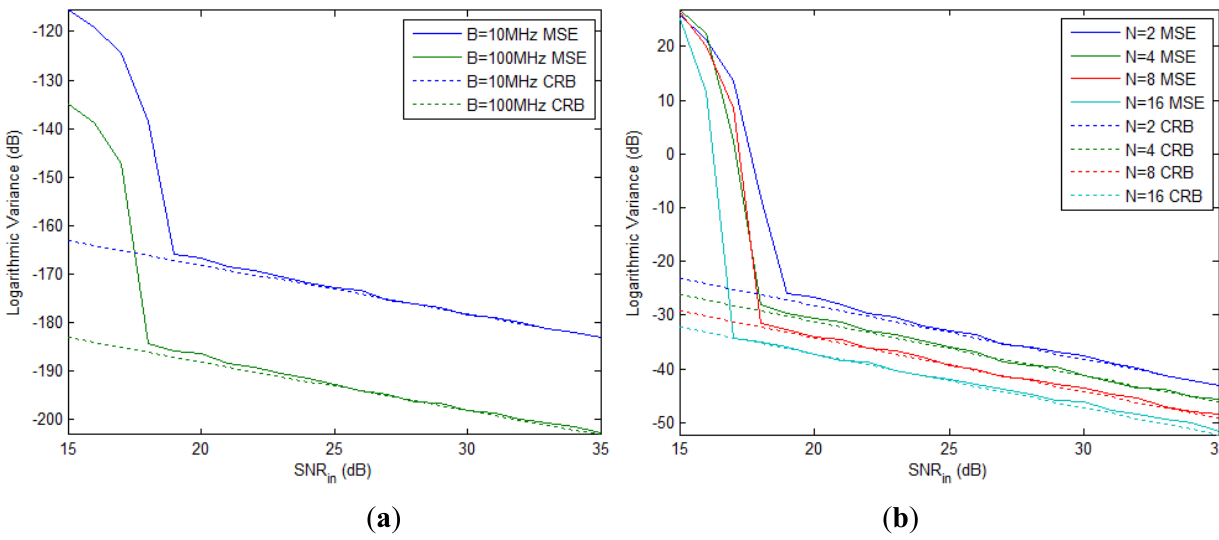
Figure 2. The logarithmic MSE and CRB of ( a ) the time delay difference and ( b ) the normalized time delay difference vs. input